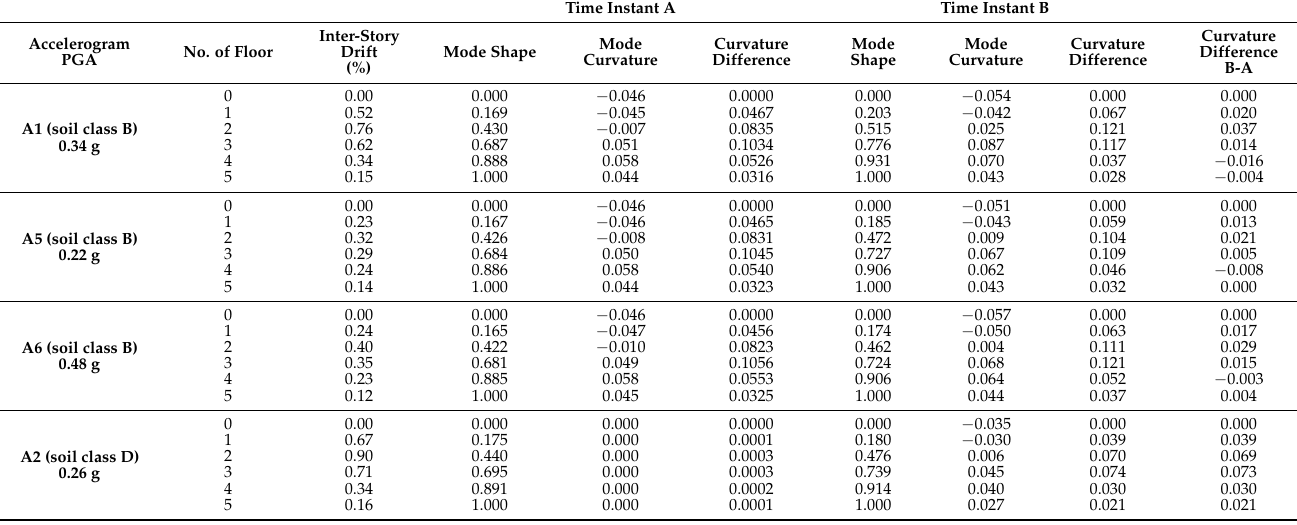
Table A3. Values of the main parameters evaluated for the 5-story numerical model with infill panels in correspondence to the fundamental mode of vibration.